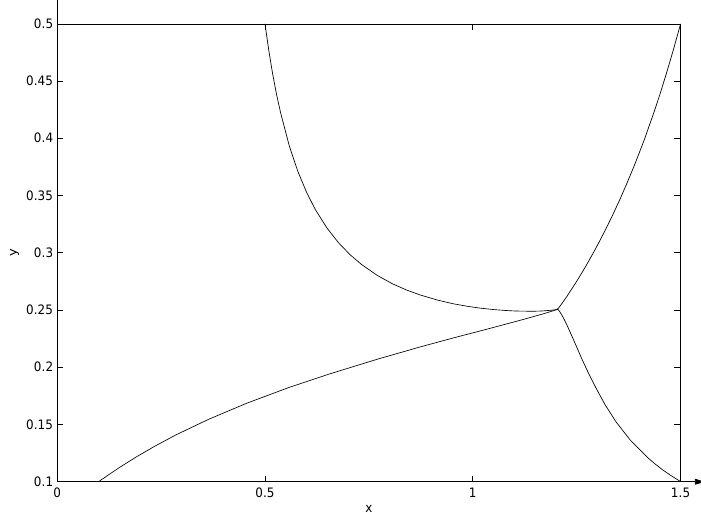
Figure 1. Four trajectories for system (14) when τ =